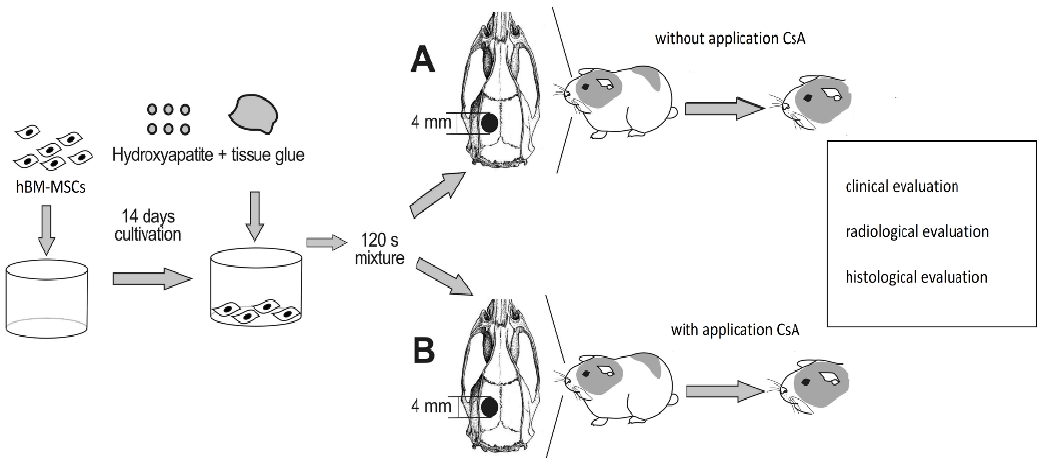
Figure 1. Schematic diagram of the experimental protocol. The biomaterial loaded with hBM-MSCs and implanted into the bone defects of guinea pigs was analyzed after two months of surgery. Group A is without application of CsA and Group B is with application of CsA. Various clinical, radiological, and histological parameters were evaluated.